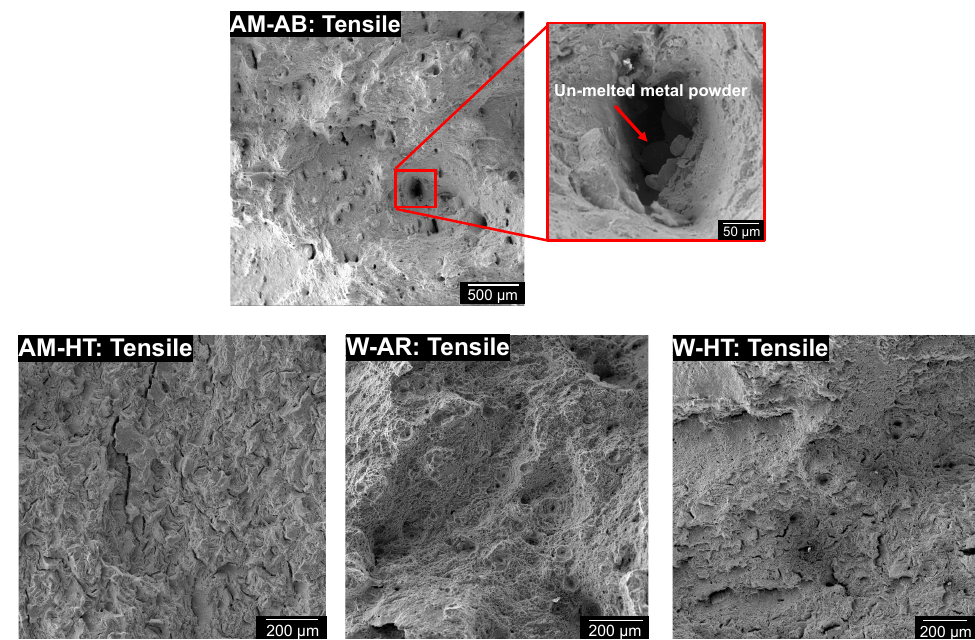
Figure 10. Sample fracture surface resulting from uni-directional tension test.